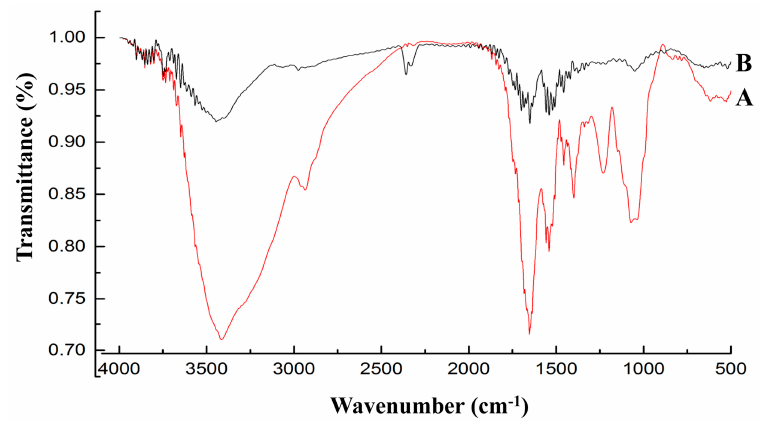
Figure 5. Fourier transform infrared spectrums of L. bulgaricus KLDS1.0207 untreated and treated with Pb (50 mg/L): ( A ) Untreated biomass; and ( B ) Biomass after Pb binding.